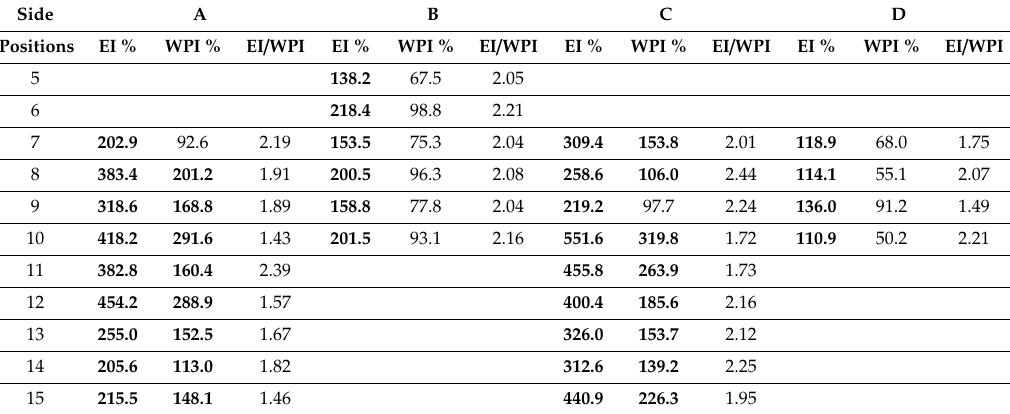
Table 6. HPCS 1 power unit master: comparison between EIs and weighted peak indexes (WPIs). Side A B C D Positions EI % WPI % EI / WPI EI